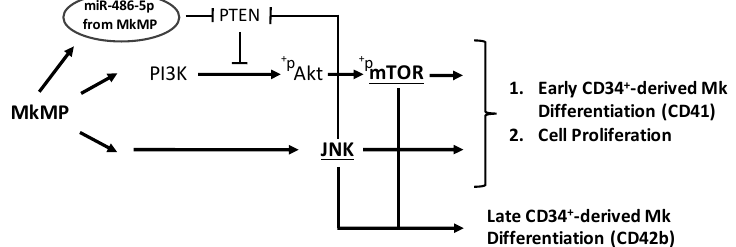
Figure 7. Schematic diagram of proposed model for MkMP-induced signaling in CD34 + HSPCs and its relationship to miRs in MkMPs. The model is based on the following pieces of evidence. Our data showed that a co-culture of CD34 + HSPCs with MkMPs activates the PI3K/Akt/mTOR and JNK signaling pathway toward cell expansion and megakaryocytic differentiation. Specifically, JNK and mTOR signaling are involved in late Mk differentiation (CD42b expression). A crosstalk between JNK and PI3K/Akt/mTOR was identified via the negative regulator of PI3K/Akt/mTOR signaling, PTEN. PI3K and PTEN were known major targets of miR-486-5p.